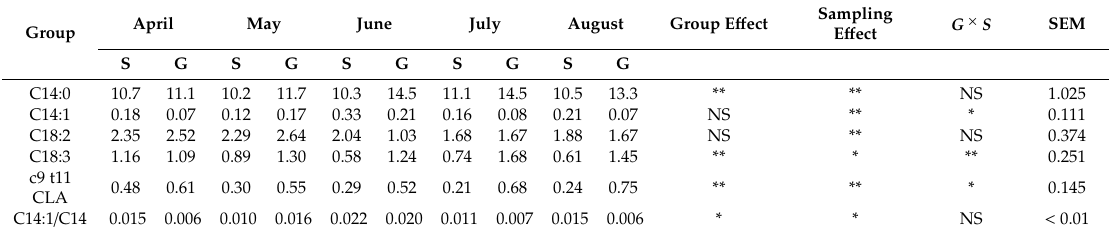
Table 4. Milk fatty acid profile (% of total fatty acid) along the